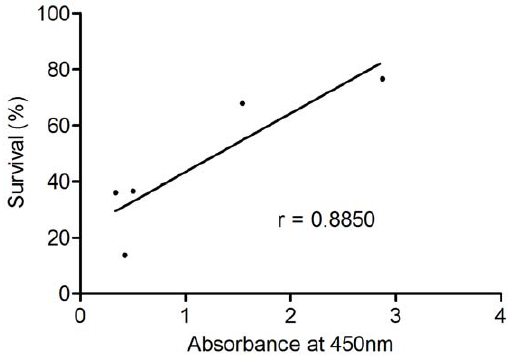
Figure 3. Antibody titers. Mean calculated titers 6 SEM for each group at each time point. The titers were calculated as described in the main text. Differences in antibody titer between control and treated groups were analyzed using the Kruskal-Wallis method. Asterisks indicate statistically significant difference between treated group and infected controls (*=P , 0.05, **=P , 0.01). See legend for identification of the experimental groups.